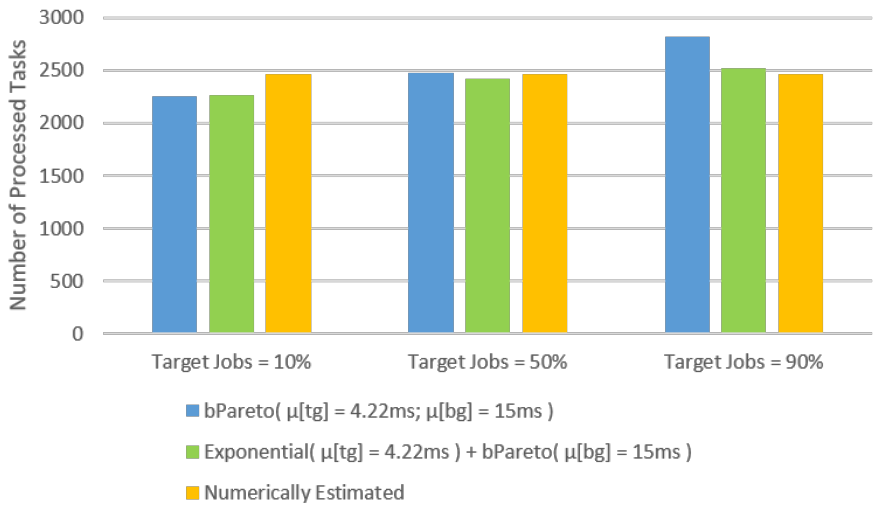
Figure 10. Samples amount required for reliable metrics, check scenarios 2 and 3 in